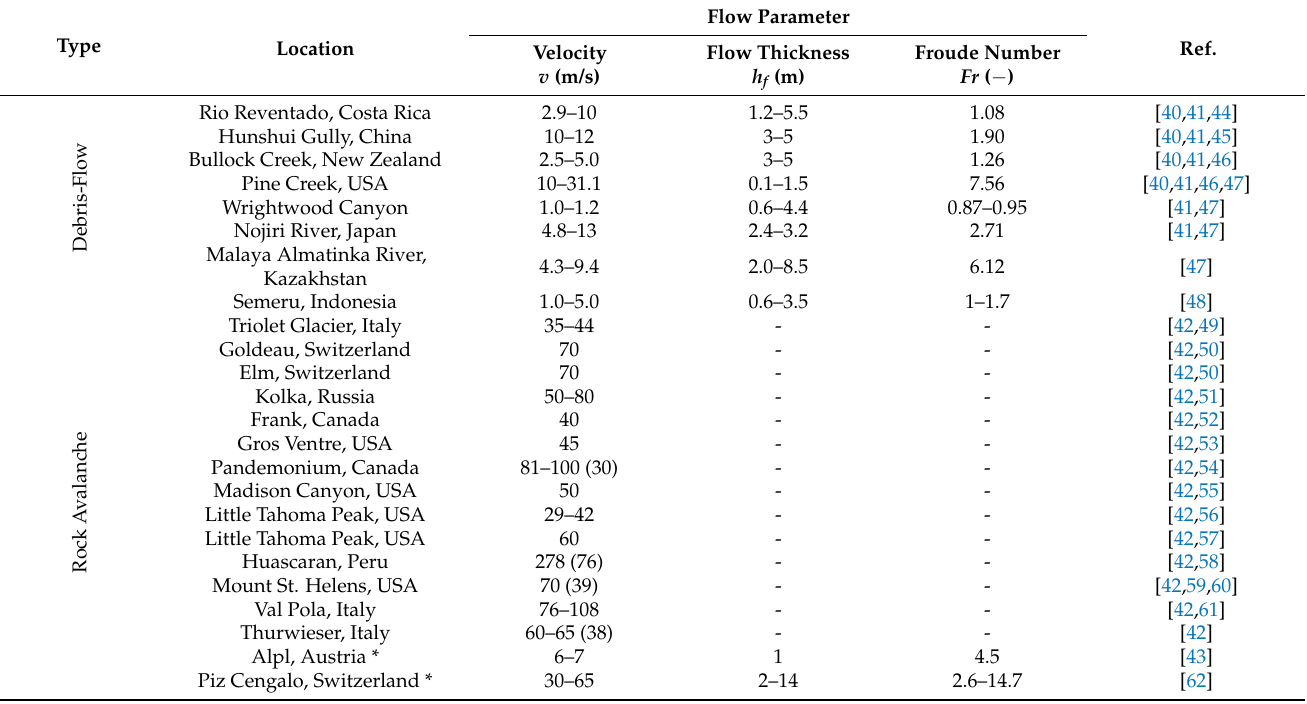
Table 6. Velocity ( v ), flow heights ( hf ), and Froude numbers ( Fr ) of debris flows and rock avalanches published in [40–62] by different authors. * Rock avalanche on snow and ice.